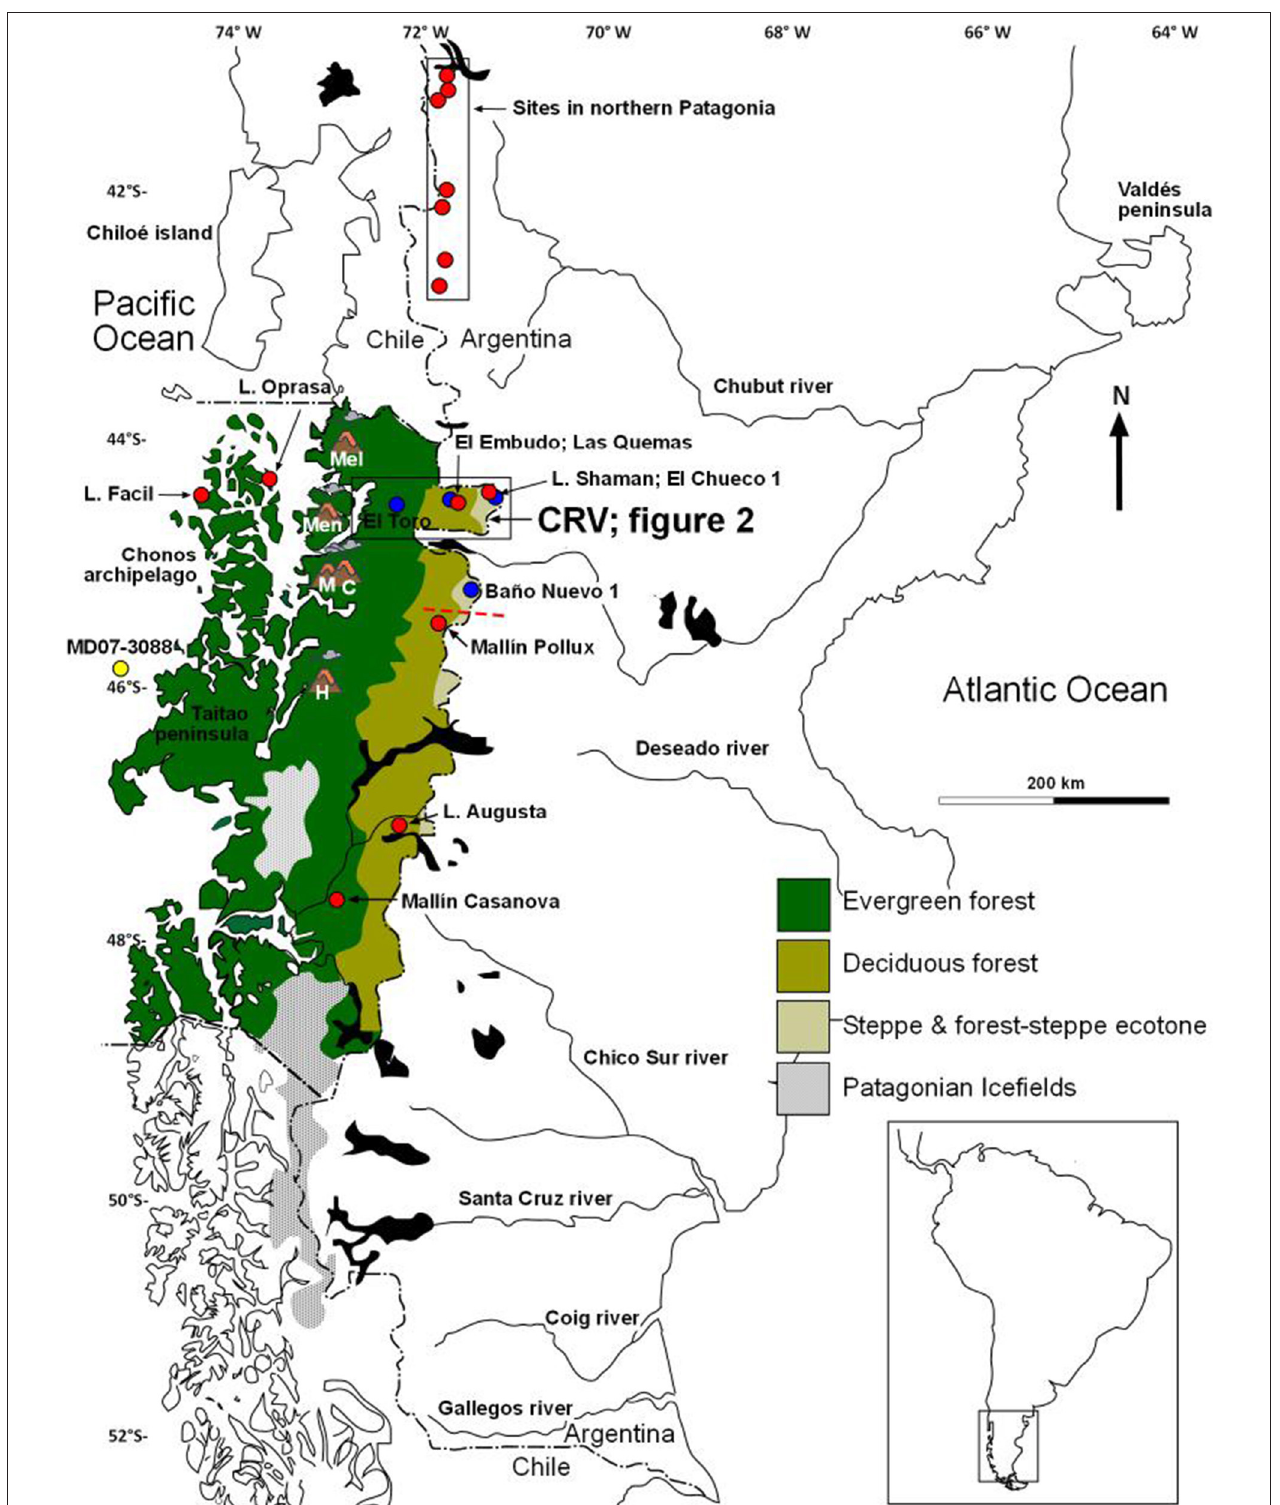
FIGURE 1 | Map of Southern South America showing the CWP, main vegetation communities, the location of the CRV, the main archeological sites (blue), the terrestrial (red), and marine (yellow) sedimentary records discussed in the text, and the location of the Melimoyu (Mel), Mentolat (Men), Maca (M), Cay (C), and Hudson (H) volcanoes.